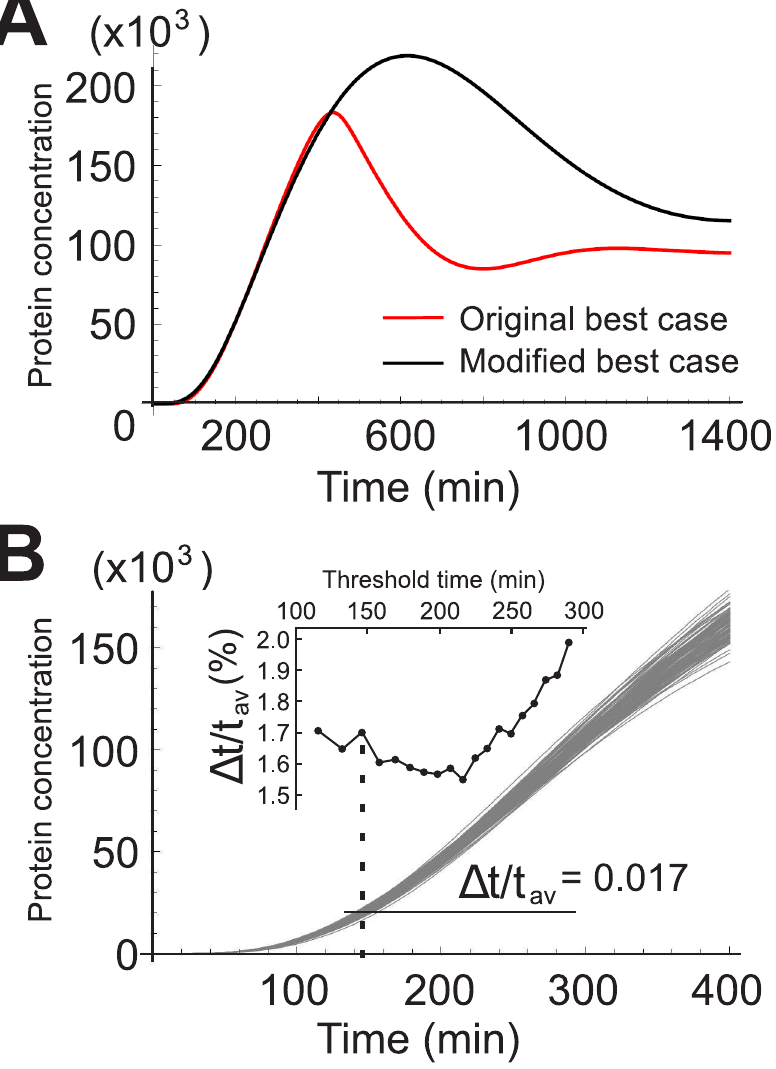
Fig 8. Importins in a steady state at t = 0. A) Average protein concentrations for Y n . The red curve corresponds to the best case discussed in Fig 4. The black curve is the profile obtained when